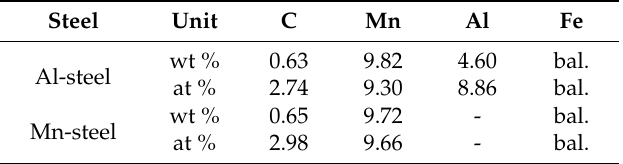
Table 1. Chemical composition in wt % and at % for the Mn-steel and Al-steel. Steel